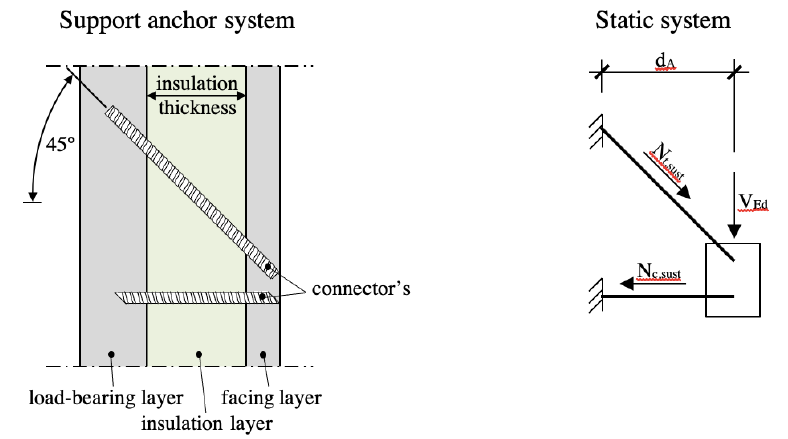
Figure 3. Support anchor system (left) and static system (right) to calculate the distribution of forces in the support anchor system due to the dead load of the facing layer V Ed .